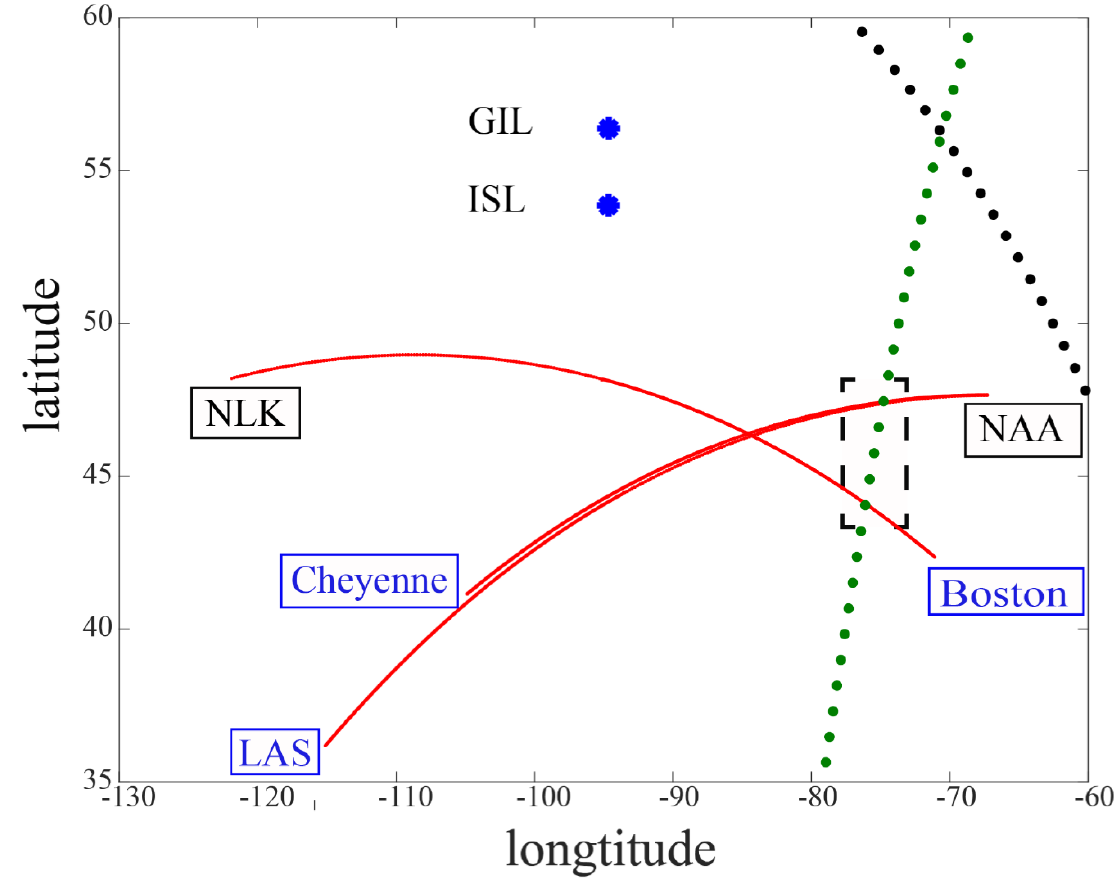
Figure 1. The location of two riometers and the footprint of the VLF propagation path and NOAA satellites mapped to the ground. The black boxes and blue boxes represent transmitters and receivers respectively in this study. The red lines show the big circles from the transmitters to the receivers. The locations of riometers are denoted as blue dots. The green and black dotted line show the corresponding tracks of the NOAA 16 and NOAA 15, respectively.